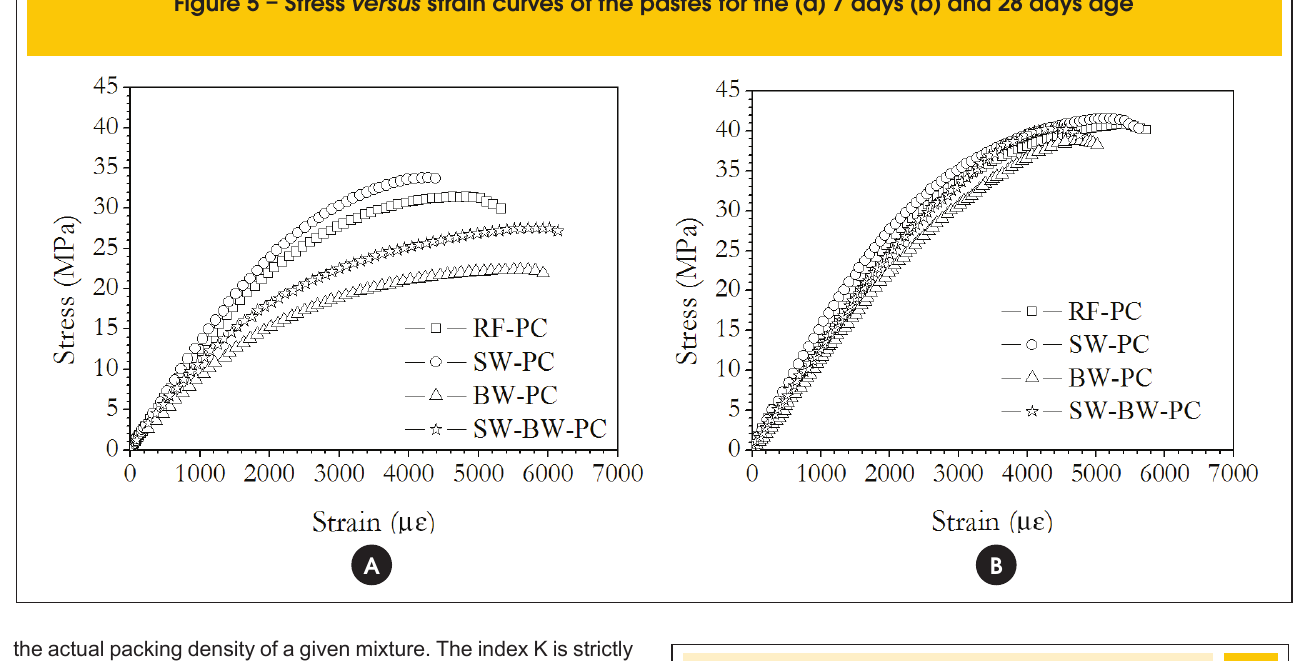
Figure 5 – Stress versus strain curves of the pastes for the (a) 7 days (b) and 28 days age